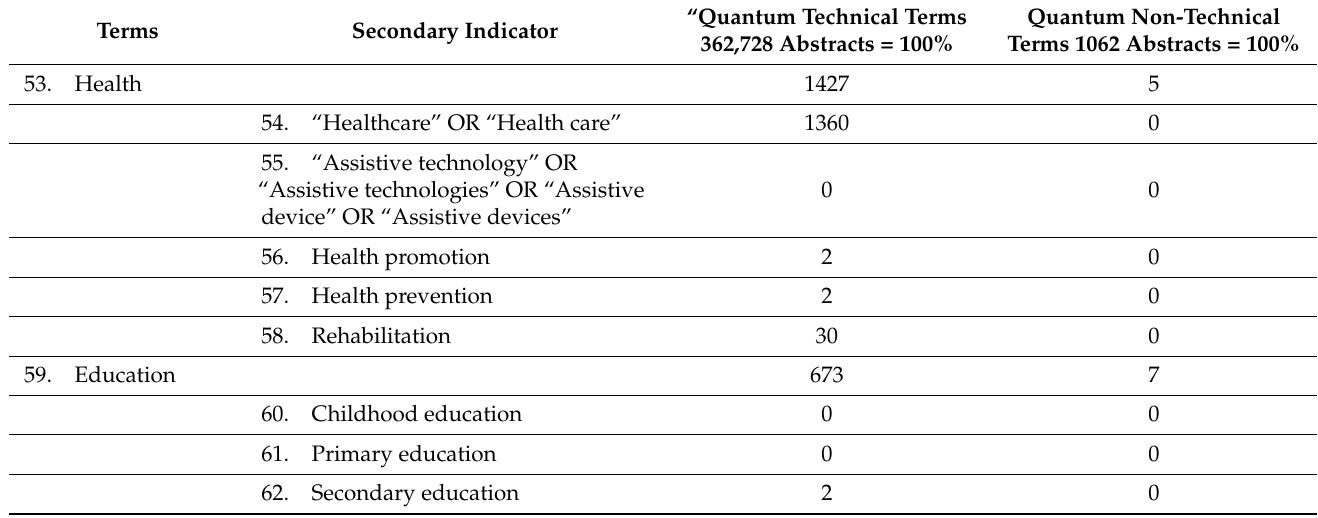
Table 5. Presence of Community Based Rehabilitation Matrix indicators in conjunction with the quantum terms